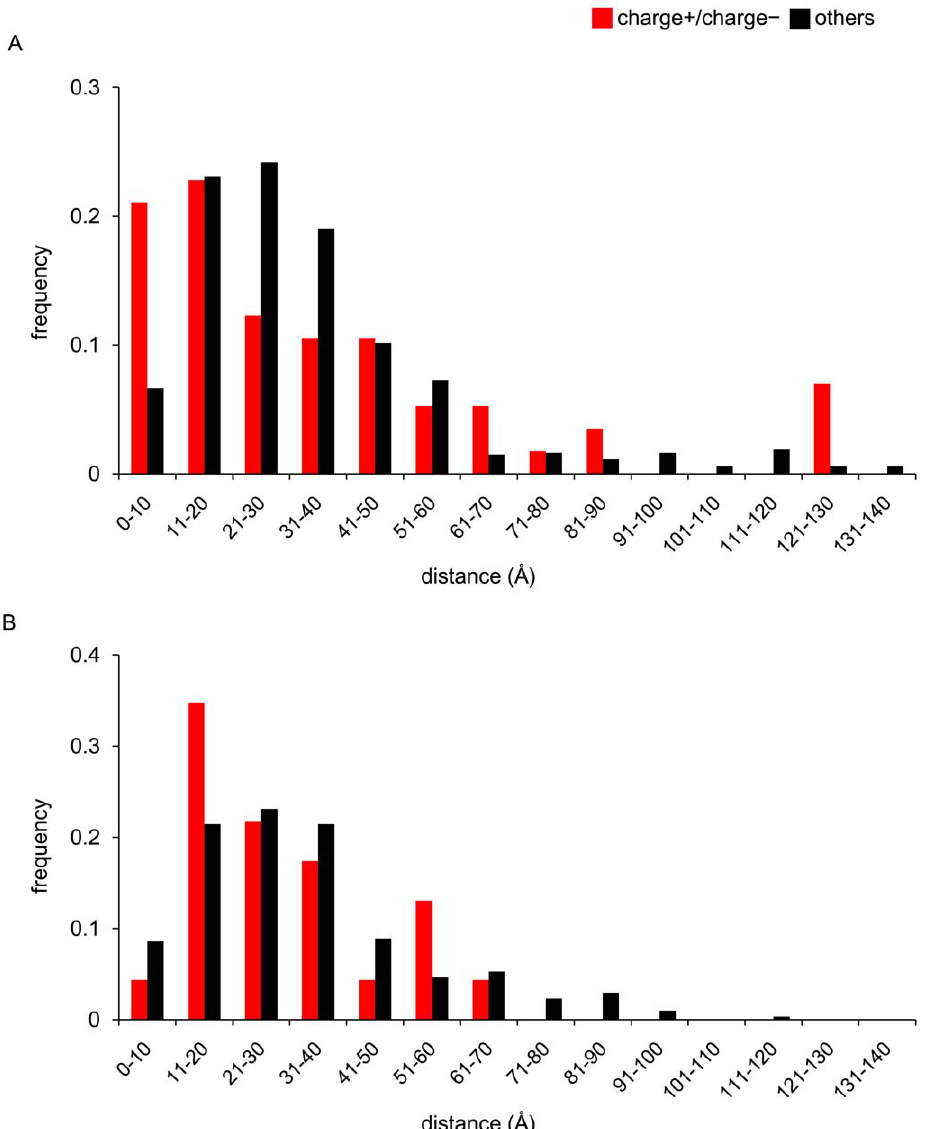
Figure 5. Distribution of distances between amino acid substitutions in HA1 occurring on the same NGS ± branches. The distances in the three-dimensional structure of HA between amino acid substitutions occurring on the same NGS 6 branches were measured for (A) A/H3N2 and (B) A/H1N1 viruses. The red and black bars indicate the proportions of distances between pairs of charge + and charge 2 substitutions and other pairs,